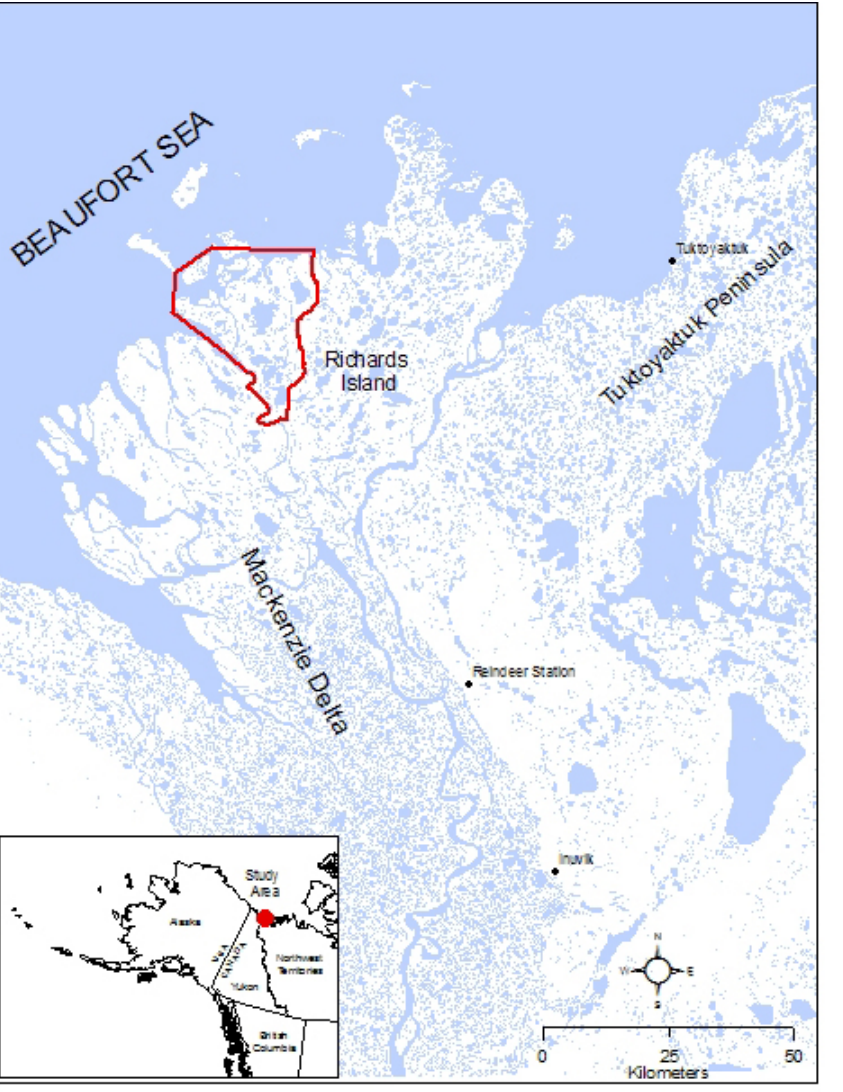
Fig. 1. Map showing the location of the Mackenzie Delta in the Northwest Territories. The red outline represents the approximate boundaries of the Kendall Island Bird Sanctuary, which is shown in more detail in Fig.